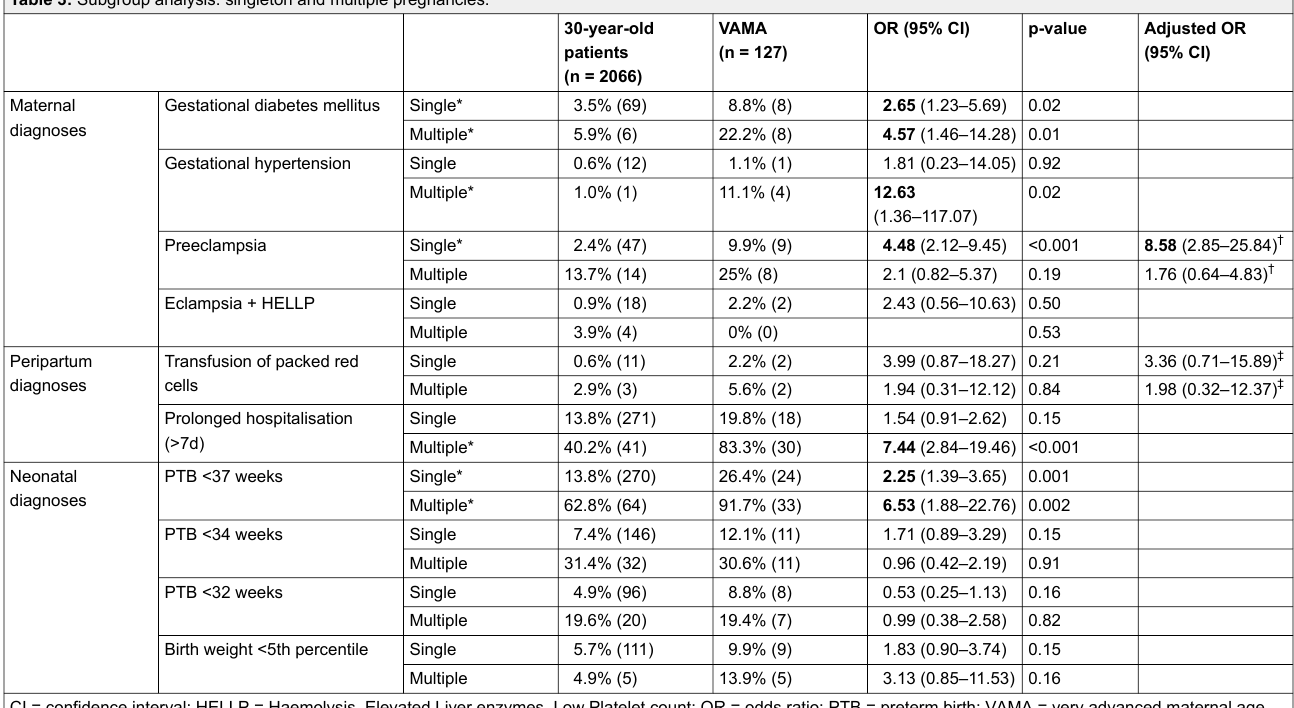
Table 3: Subgroup analysis: singleton and multiple